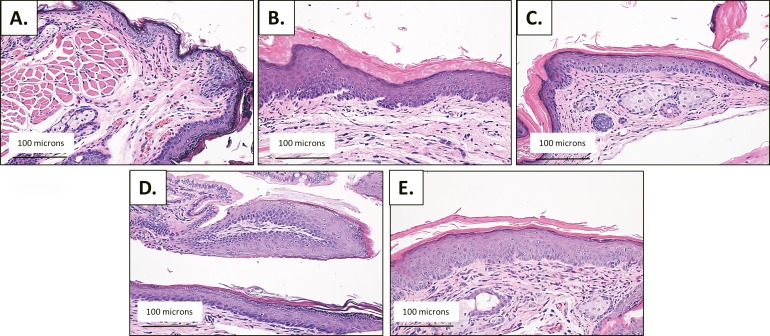
Histological analysis of the anal transition zone at various time points in FVB/N mice during DMBA treatment time course.Anal histology identified by a trained pathologist for each time point (25 mice/group) following treatment with and without DMBA (0.12μmole topically to anus weekly). A) H&E staining of animals not treated with DMBA at the 5 week timepoint reveals normal epithelium. (B) Following 5 weeks of DMBA treatment, there is inflammation seen on H&E staining. (C) At 10 weeks of DMBA treatment there is histological evidence of low-grade dysplasia. (D) Low-grade dysplasia is present at 15 weeks of DMBA treatment and (E) high-grade dysplasia at 20 weeks of DMBA treatment. All images are acquired at 20x magnification.